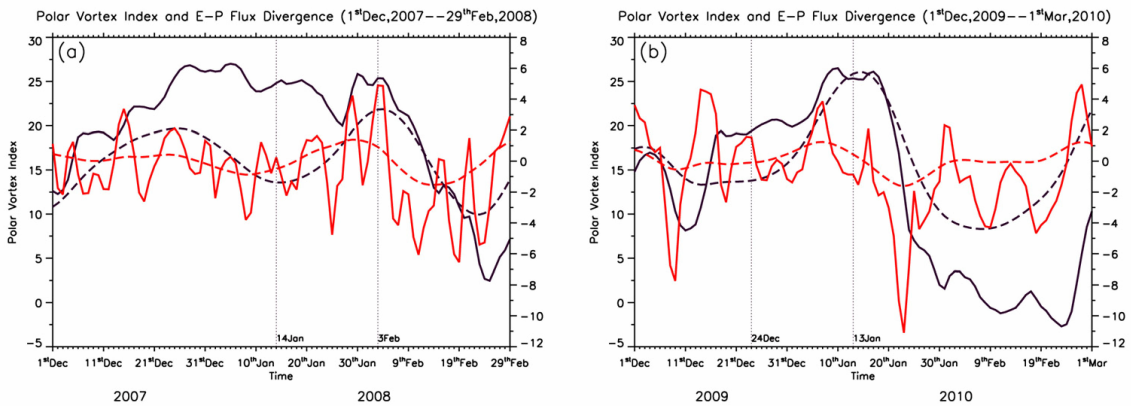
Figure 9. ( a ) The Polar Vortex index and E-P flux divergence of the 2007/08 winter. The right vertical axis represents the polar vortex index. The left vertical axis represents the E-P flux divergence and the band passes of the E-P flux divergence and the polar vortex index. The red line represents the E-P flux divergence, and the red short-dotted line represents its band pass of 30–60 days. The black line represents the polar vortex index and its 30- to 60-day band pass. The period from 14 January to 3 February 2008, is the positive AO/NAM event. ( b ) The Polar Vortex index and E-P flux divergence of the 2009/10 winter. The period from 24 December 2009, to 13 January 2010 is the negative NAO